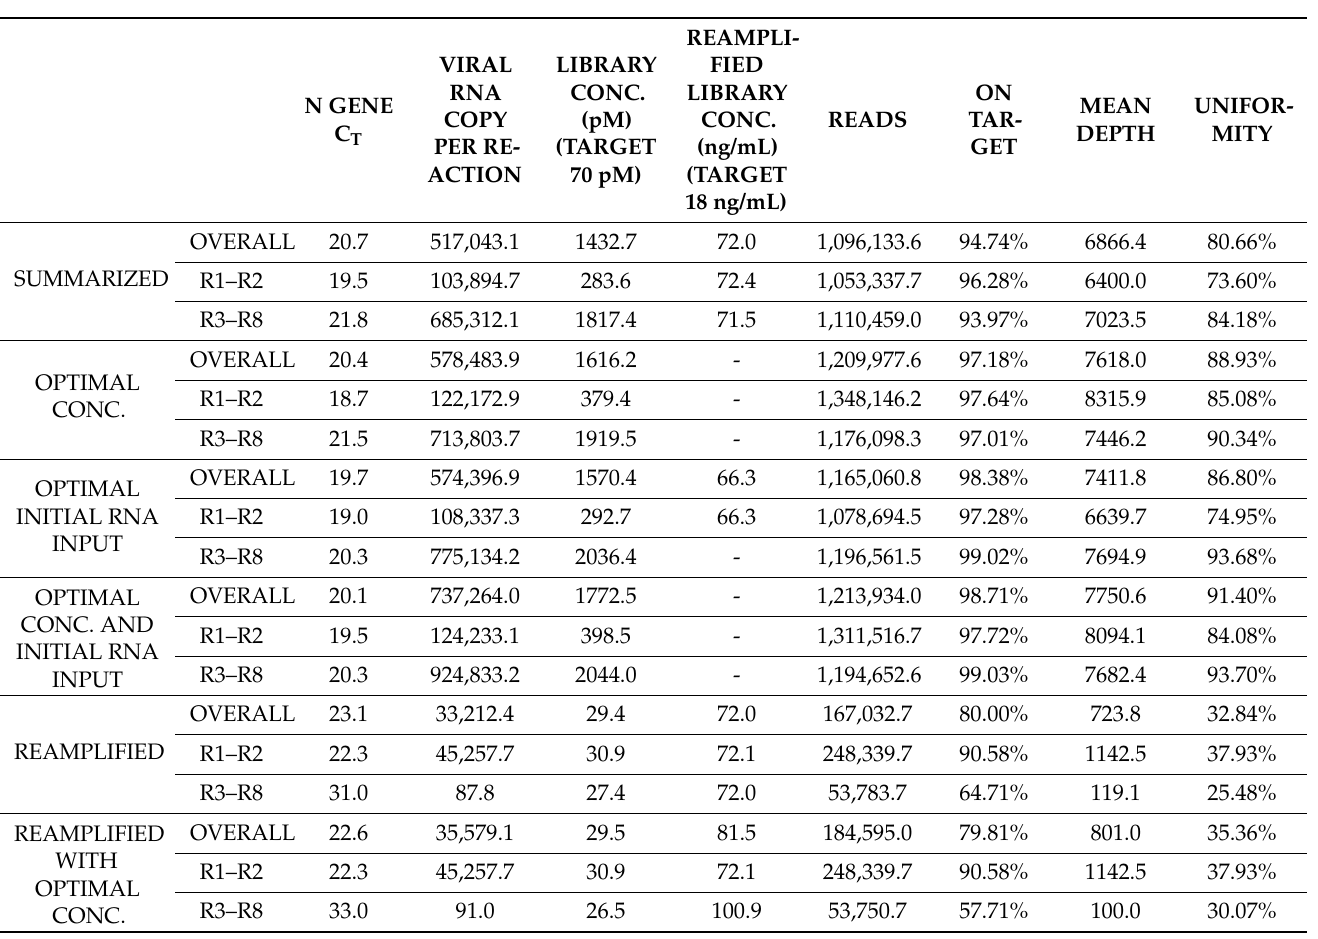
Table 3. Mean parameters of samples and libraries constructed within the study; basic quality metrics of sequencing runs